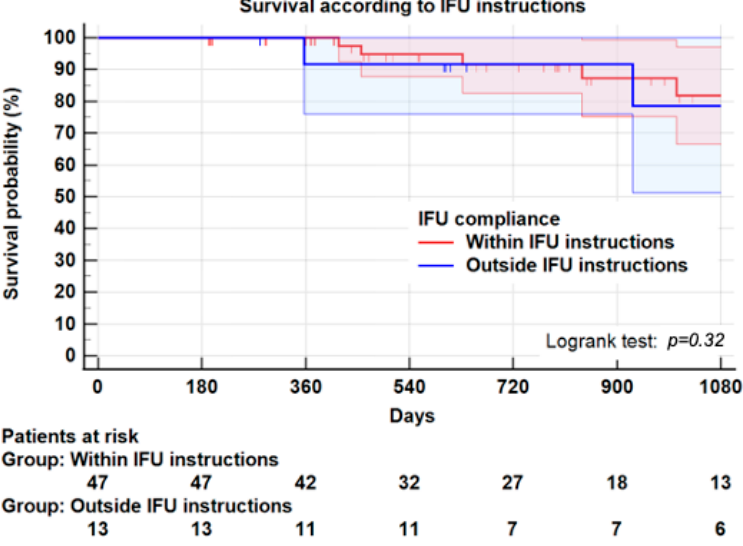
Figure 7. Kaplan–Meier plot for survival according to compliance with IFU instructions. At 3 years, survival was 81.8 ± 7.0% in patients compliant with IFU instructions and 78.6 ± 13.0% in patients non-compliant with IFU instructions, p = 0.32.